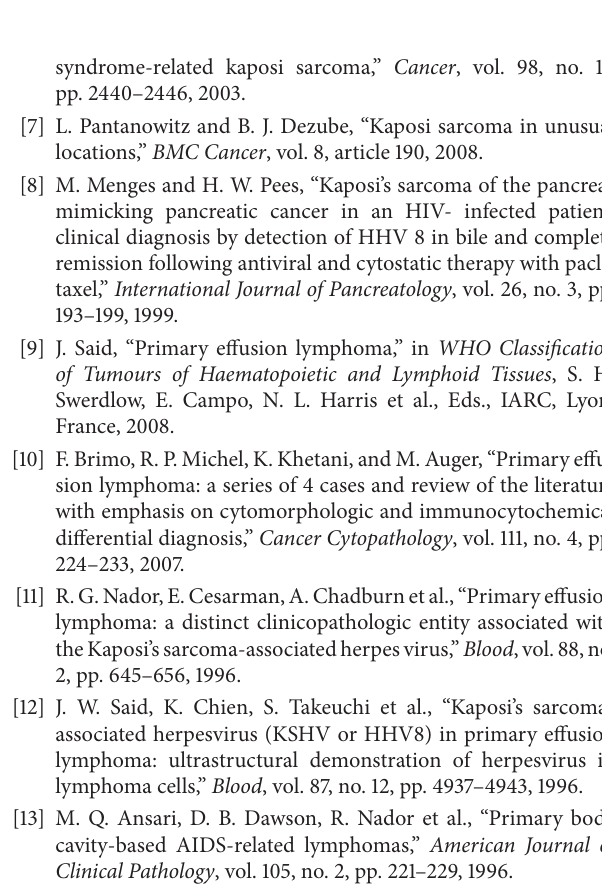
Figure 4: Kaposi’s sarcoma with well-circumscribed areas of raised hemorrhagic mucosa in large intestine ((a), (b)) and stomach ((c), (d)).